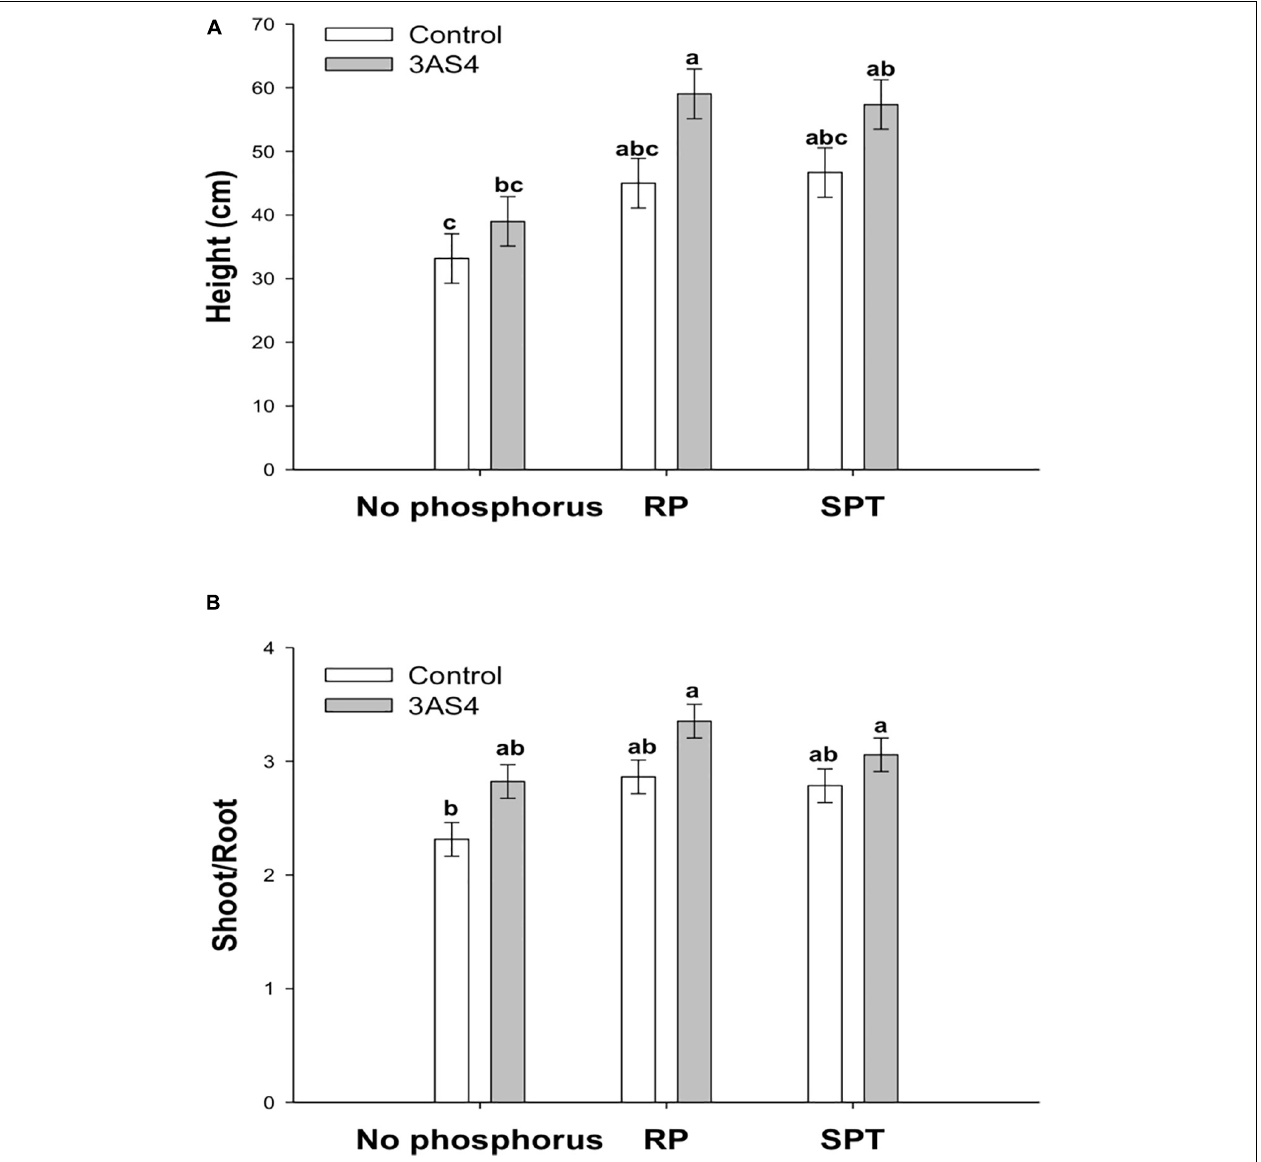
FIGURE 4 | Comparison of the height (A) and shoot:root ratio (B) of the soybean plants inoculated with the 3AS4 strain with two different sources of phosphorus. Rock phosphate (RP) and Single super phosphate (SPT) at 40 kg ha − 1 . The histograms with the same letter at each case are not significantly different at P < 0.05 (Tukey’s